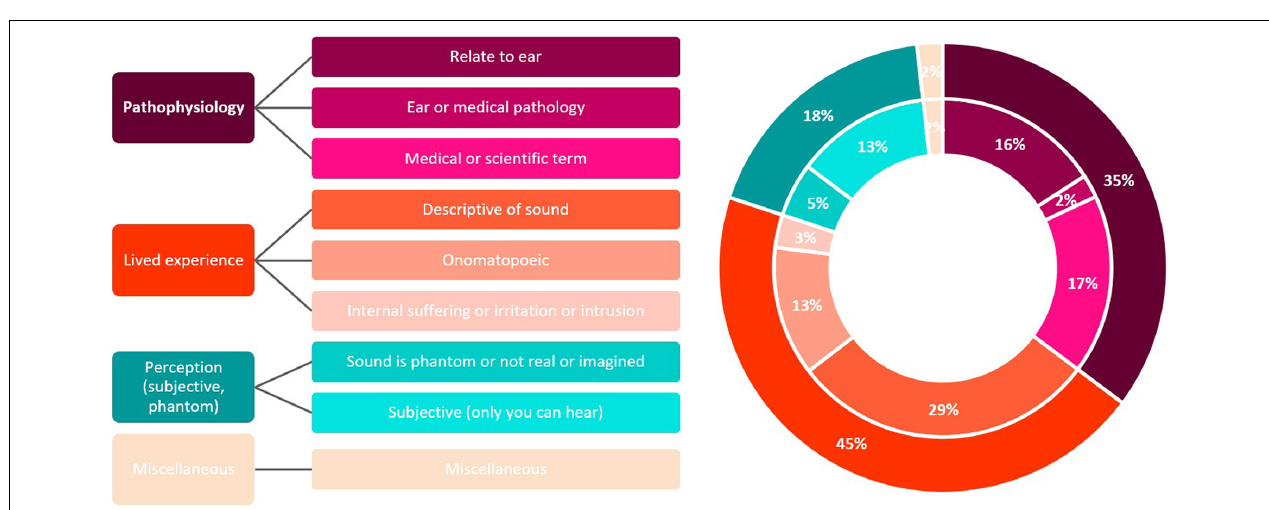
FIGURE 2 | Codes and themes identified by the bottom-up thematic analysis, which was conducted by two researchers